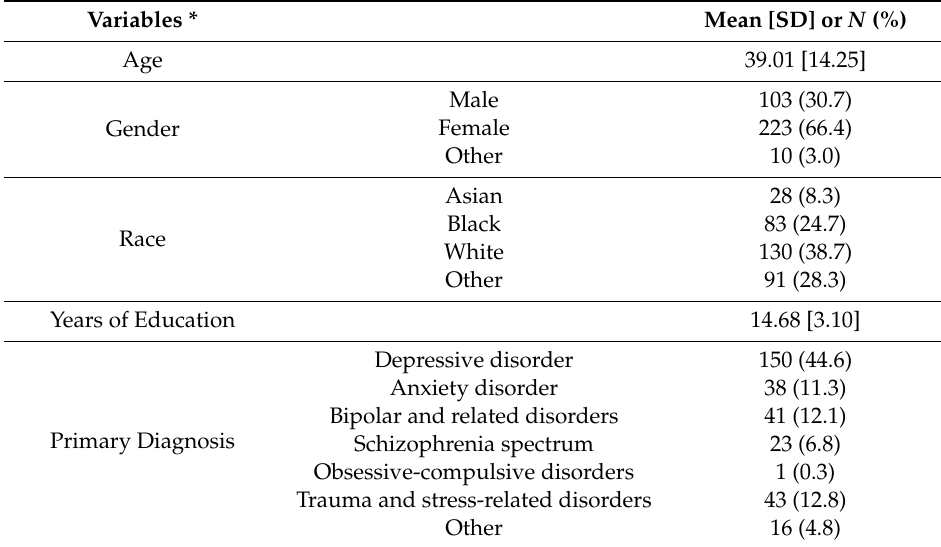
Table 1. Sociodemographic and clinical features of the sample ( N =